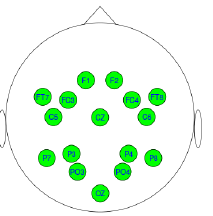
Figure 3. Scalp map of EEG